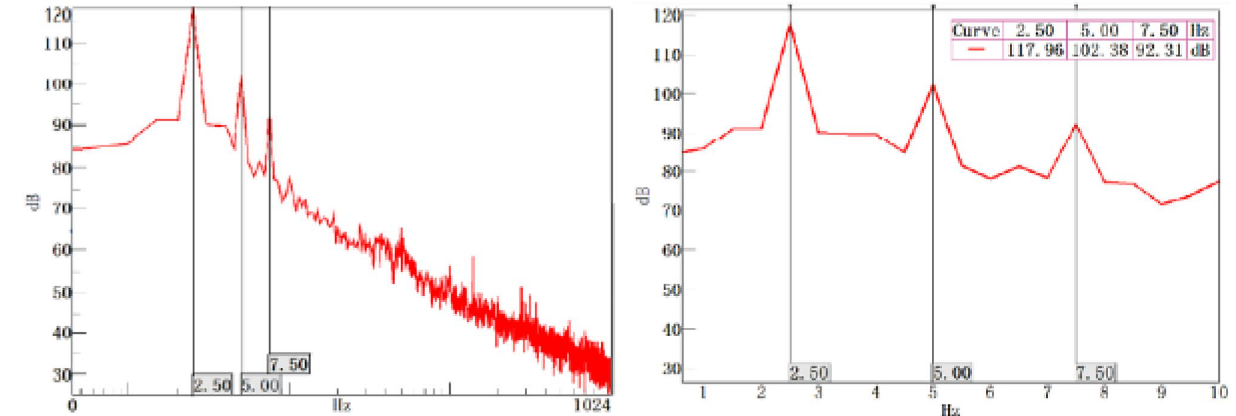
Figure 12. Power Spectral Density Function at 33 m/s.